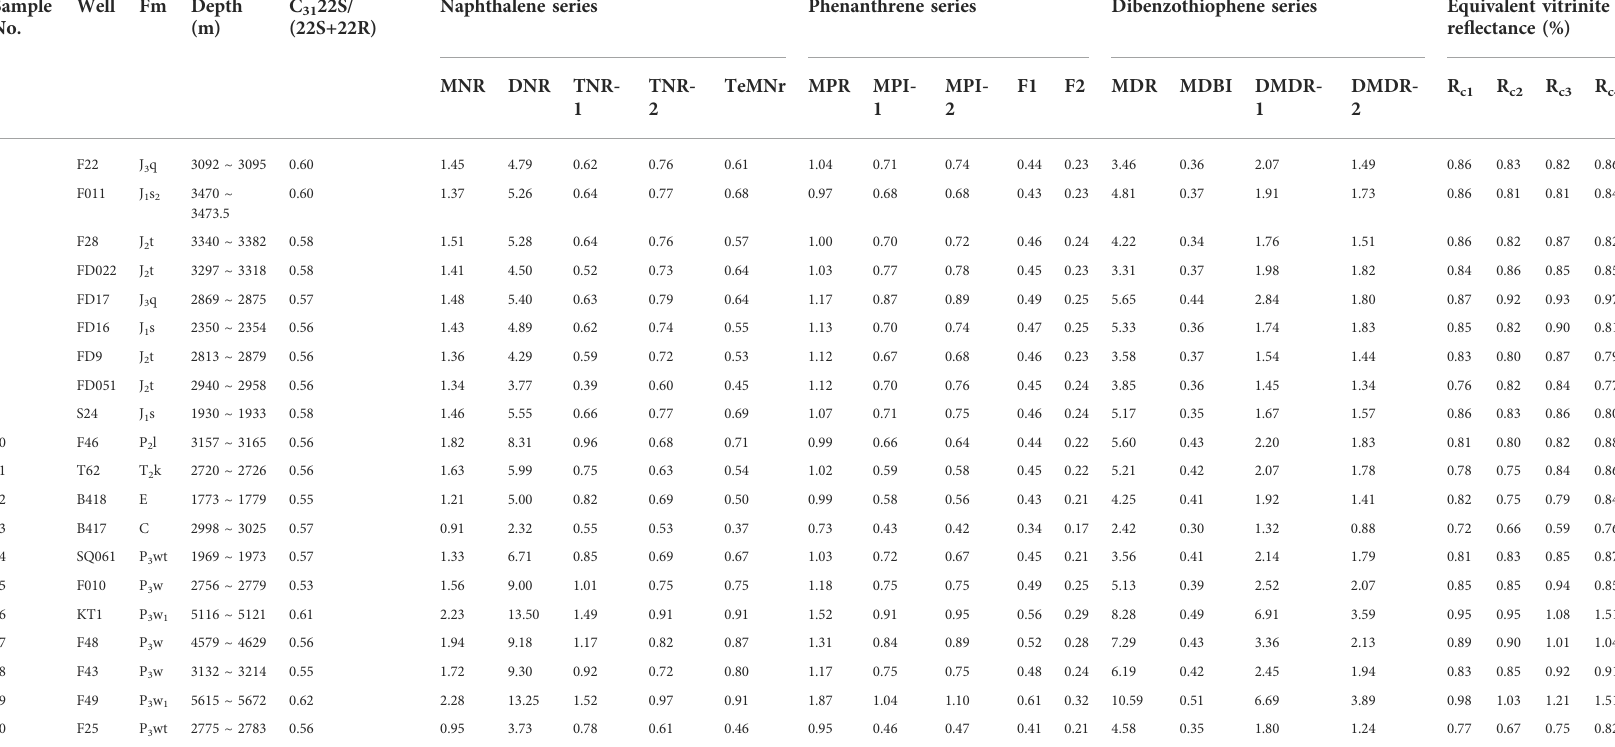
TABLE 3 Aromatic hydrocarbon maturity parameters in crude oil from the East Fukang Sag. Sample